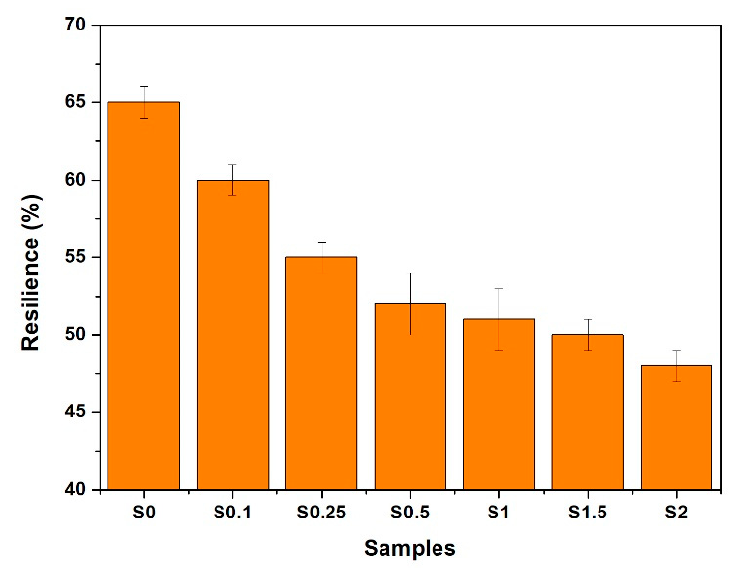
Figure 6. The variation in resilience in NR foams containing different content of GNS/CNT hybrid. A correlation between the hardness of the foams was observed with the increase in the hybrid filler loading levels, while the correlation between the resilience and the hybrid filler content was inverse. For instance, adding only 0.1 phr of CNT/GNS to the NR foam increased the hardness from 35 to 39 Shore A and decreased the resilience from 65% to 60%, while adding 2 phr of CNT and GNS had no effect on the hardness while substantially reducing the resilience (48 − 50%). Increasing the CNT/GNS